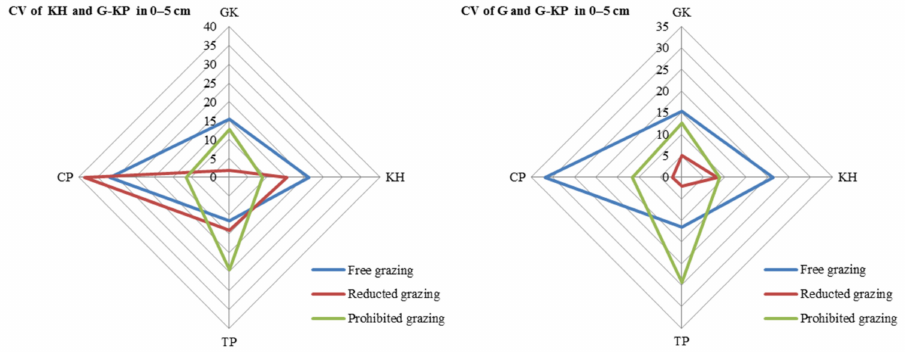
Figure 8. Variation in soil organic matter content between micro-patches in the plant community degradation process. Notes: CV of KH and G-KH: coefficient of variation at the 0–5 cm layer between the Kobresia and Kobresia - Gramineae transitional micro-patches, respectively; GK, Gramineae- K. humilis meadow; KH, K. humilis meadow; TP, K. pygmaea meadow with mattic epipedon thickening; CP, K. pygmaea meadow with mattic epipedon.